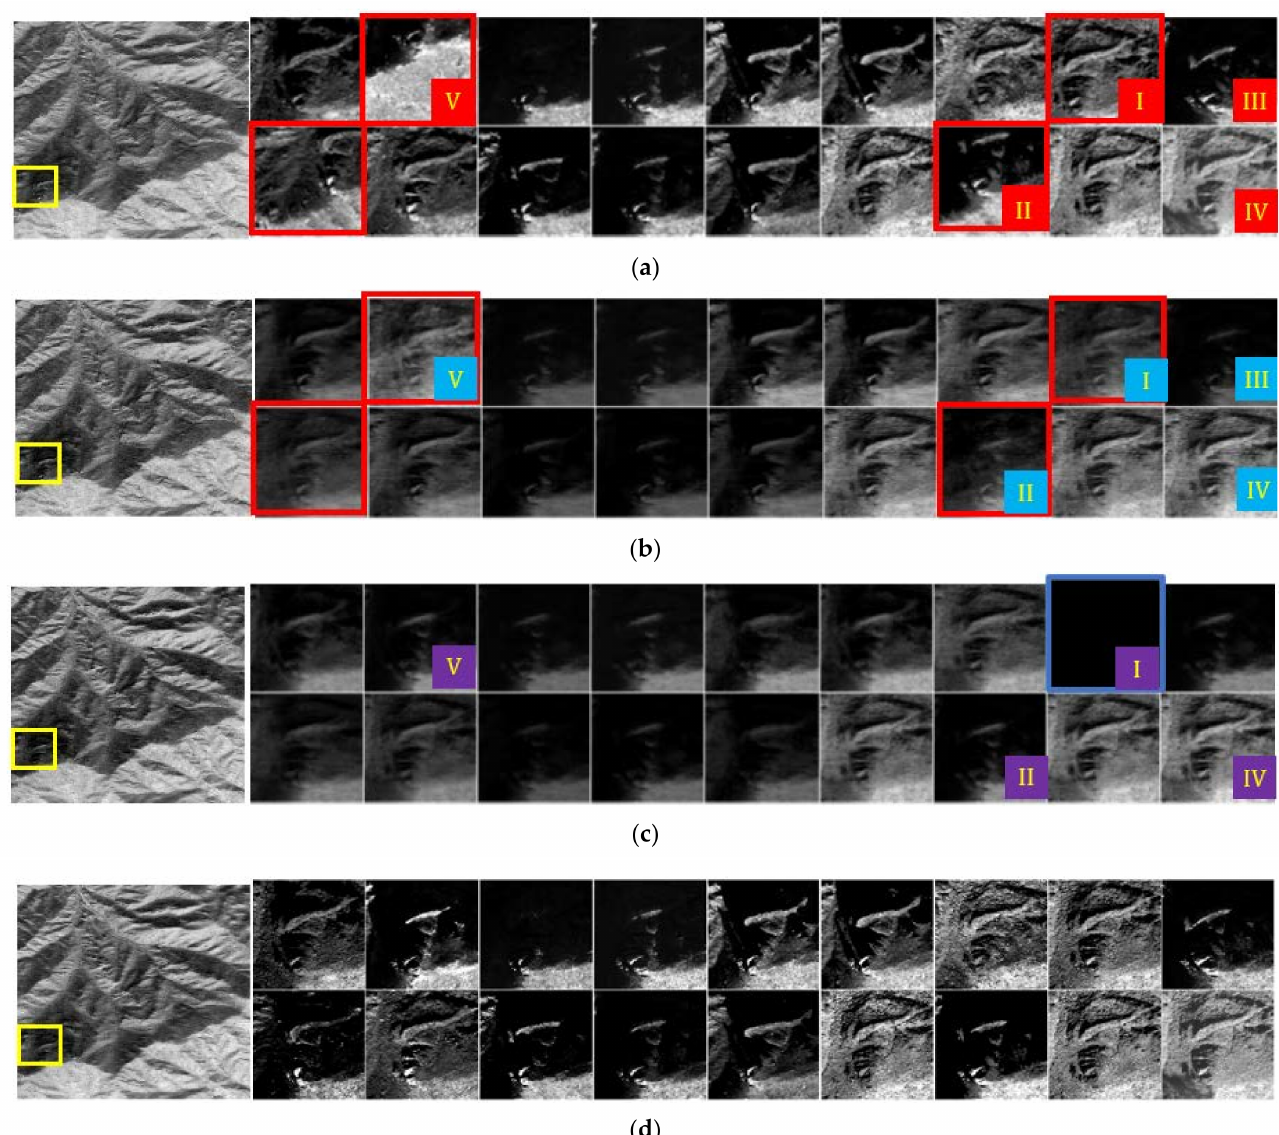
Figure 6. Global mean image (3600 × 3900 pixels) and local areas (600 × 650 pixels) of the remote sensing image sequence and relevant results by LRC-BRE and CCFR in an ecological reserve. The leftmost images of ( a – d ) are the global mean images of the original image sequence, the stable feature image sequence restored by LRC-BRE, the stable feature image sequence restored by CCFR, and the image sequence registered by CCFR, respectively. The right images of ( a – d ) are the local area of the above image sequence, whose spatial position corresponds to the yellow box on the left